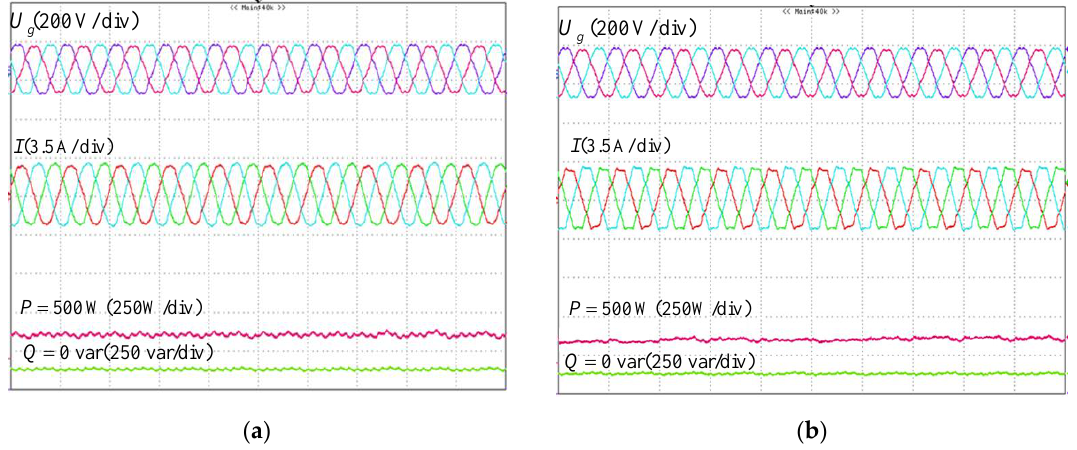
Figure 10. Experimental results of VSC under integer harmonics grid with the proposed control. ( a ) Target I sinusoidal current; ( b ) Target II, steady power without ripples.